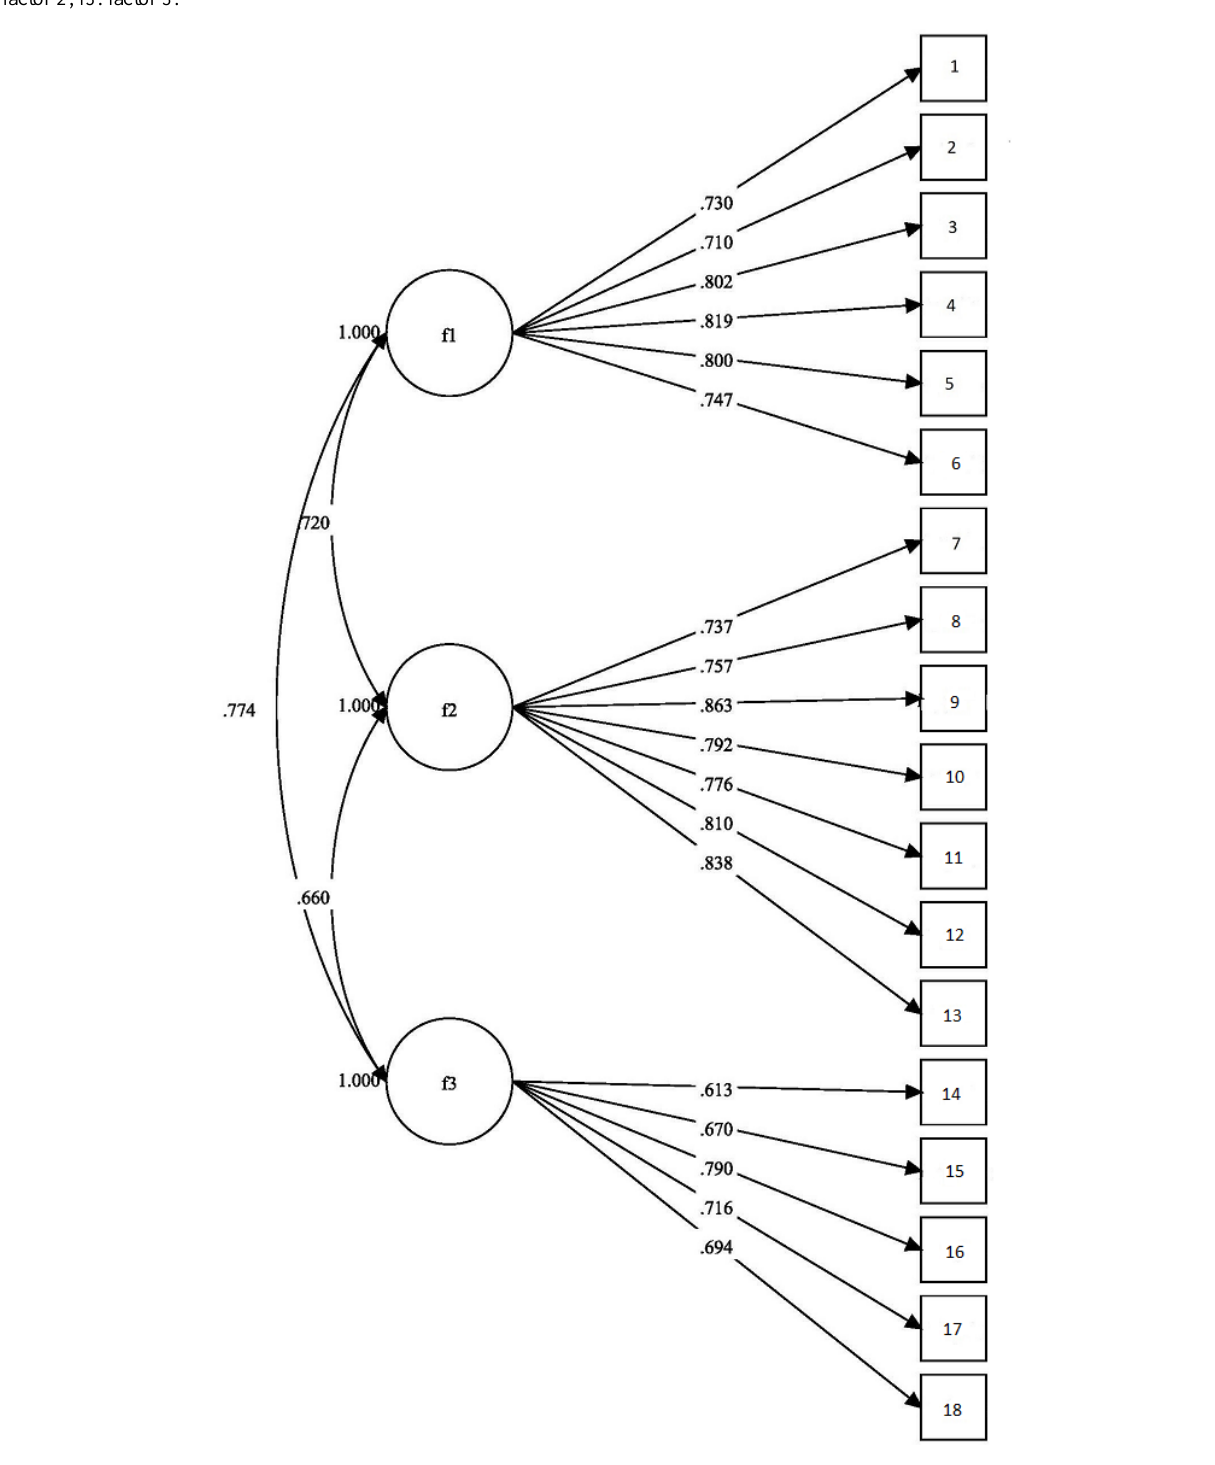
Figure 1. Factor structure with standardized loading for the 18-item Adolescents’ Digital Technology Interactions and Importance scale. f1: factor 1; f2: factor 2; f3: factor